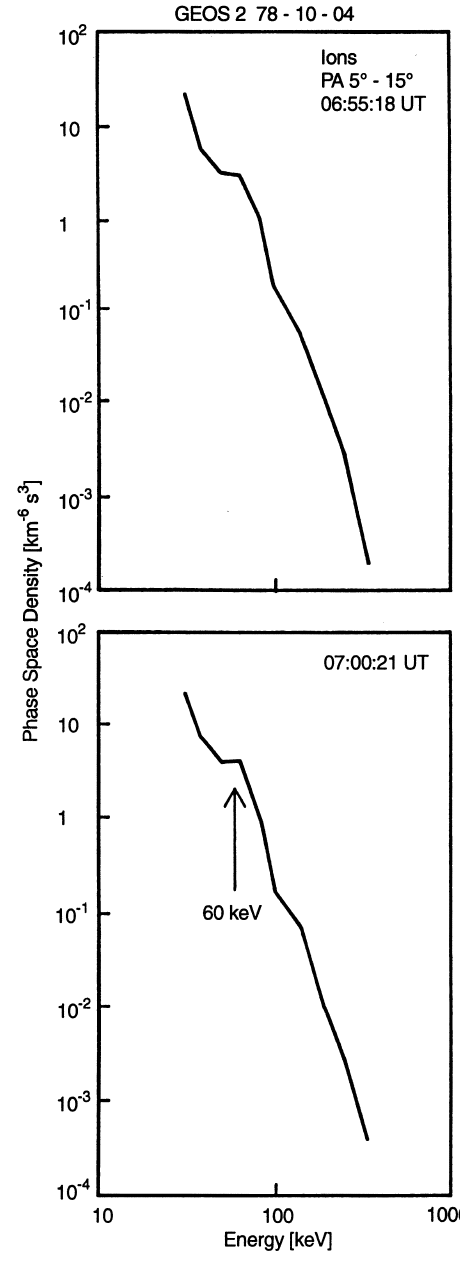
Fig. 7. Phase space density of energetic protons recorded onboard GEOS-2 in the pitch-angle range 5 (cid:14) –15 (cid:14) on October 4, 1978, 0655:18 and